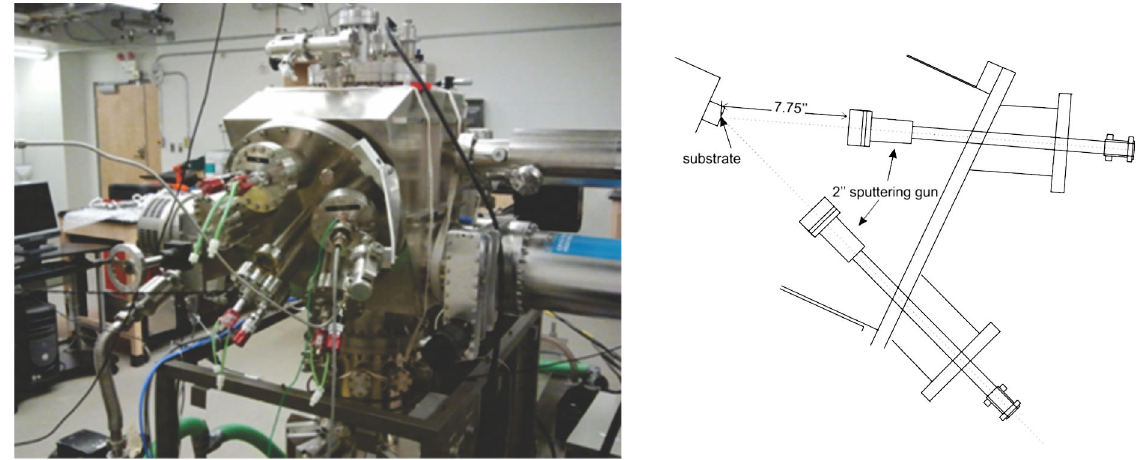
FIG. 3. Left: Rear view of the Perkin-Elmer deposition chamber where we note five source ports with confocal geometry. Right: Diagram showing the relative position of two of the five sputtering sources with respect to the